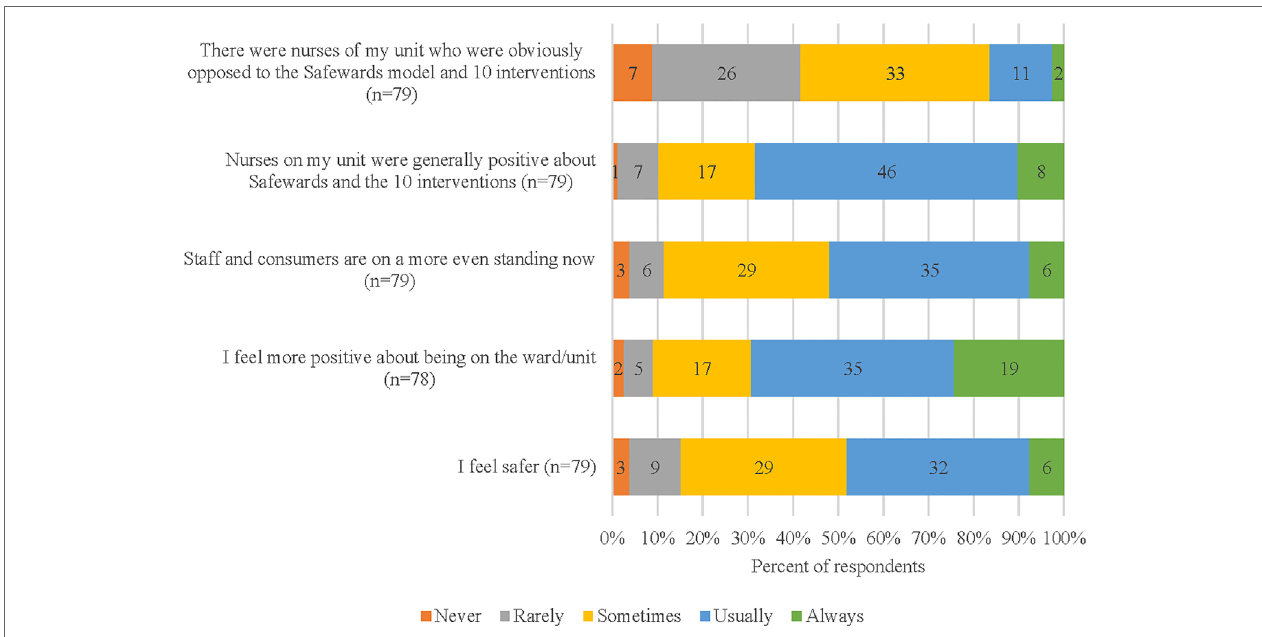
FIGURE 2 | Staff reports of the impact of Safewards on the feel of the